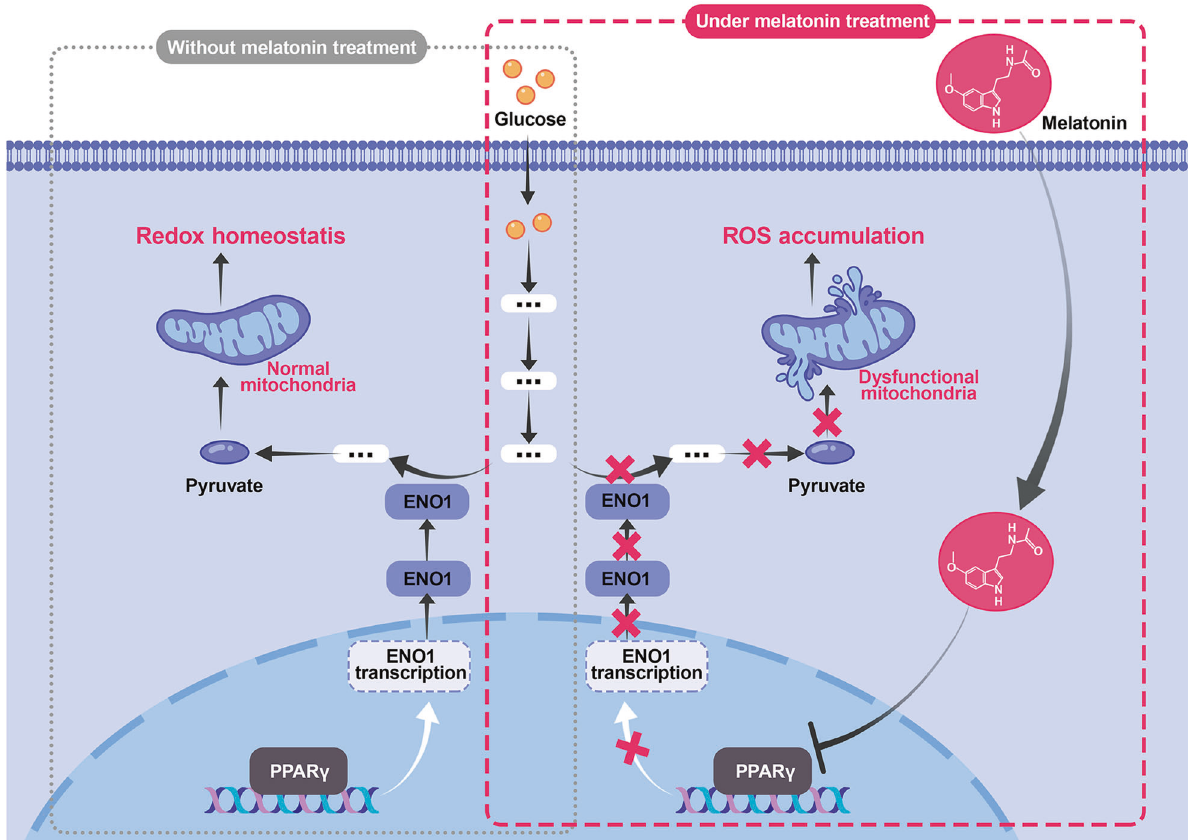
Fig. 7 Melatonin inhibited tumorigenesis of bladder cancer via suppressing PPAR γ /ENO1-mediated glycolysis. Left panel: without melatonin treatment, PPAR γ promotes ENO1 transcription to complete the integral glycolysis process, and the mitochondrion function normally to maintain cellular redox homeostasis. Right panel: under melatonin treatment, melatonin inhibits PPAR γ -ENO1-mediated glycolysis. Decreased pyruvate production causes increased mitochondrion burden leading to abnormal ROS